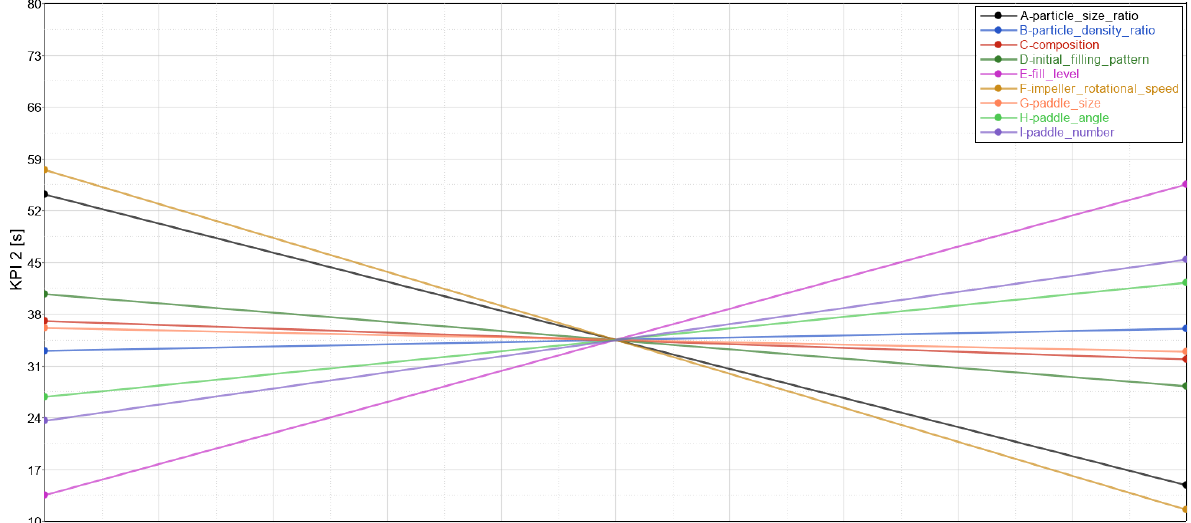
15 of 22 Figure 8. Pareto plot for KPI 2 mixing time. Table 7. Analysis of variance (ANOVA) results of KPI 2 mixing time. Factor